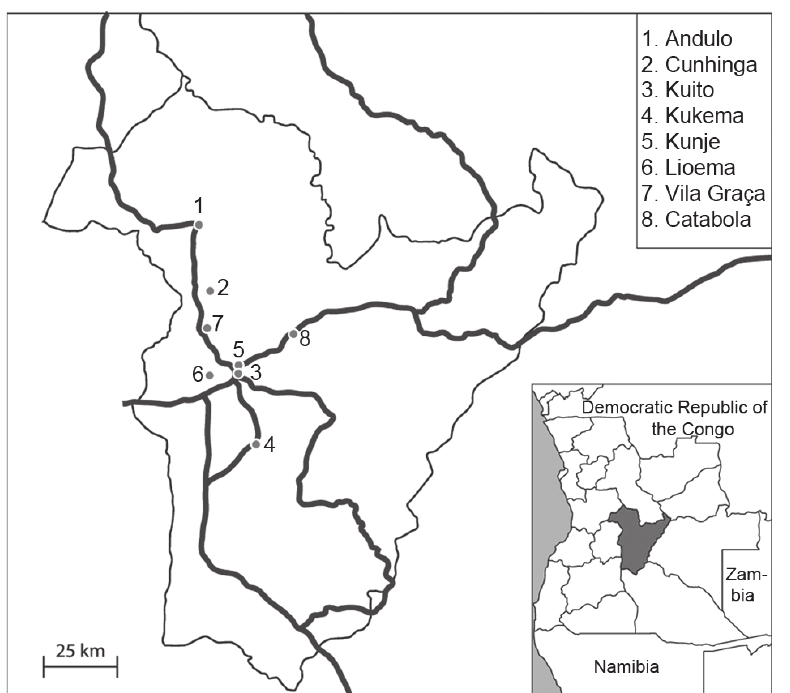
Fig. 1. – Distribution of sampling sites in Bié Province (dots). Numbers at each locality correspond to those in the Table II. Position of Bié Province in the territory of Angola is evident on small inserted map at right down